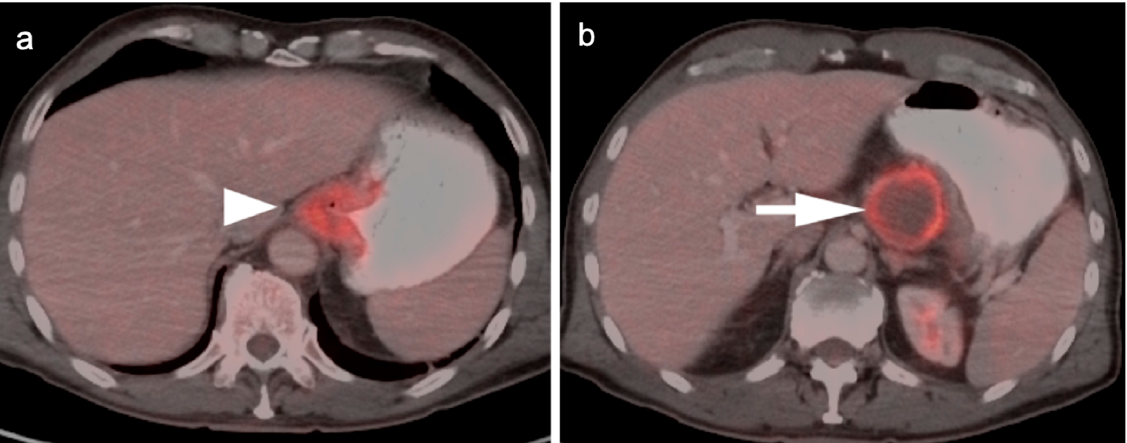
Figure 4. Upper thoracic esophageal cancer. ( a ) Axial fused FDG PET-CT axial image demonstrates a single hypermetabolic low right level 3 cervical node (white arrowhead); ( b ) Axial fused FDG PET-CT image shows that the primary tumor is a hypermetabolic eccentric mass in the upper thoracic esophagus (white arrow). Upper esophageal tumors frequently have nodal spread to the low neck or supraclavicular region.